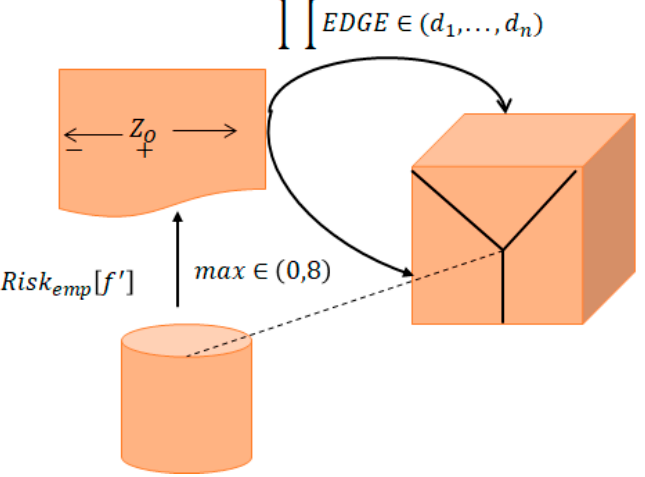
Figure 3. Illustration of maximum error bounds for risk estimation global function.